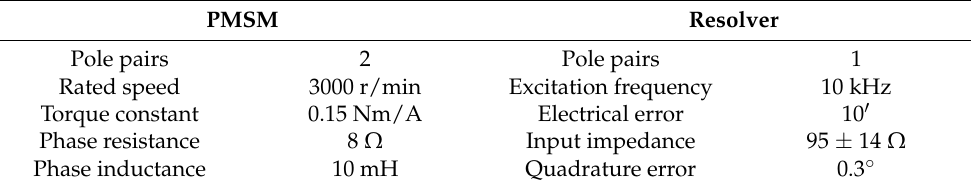
Table 3. Parameters of PMSM and resolver.